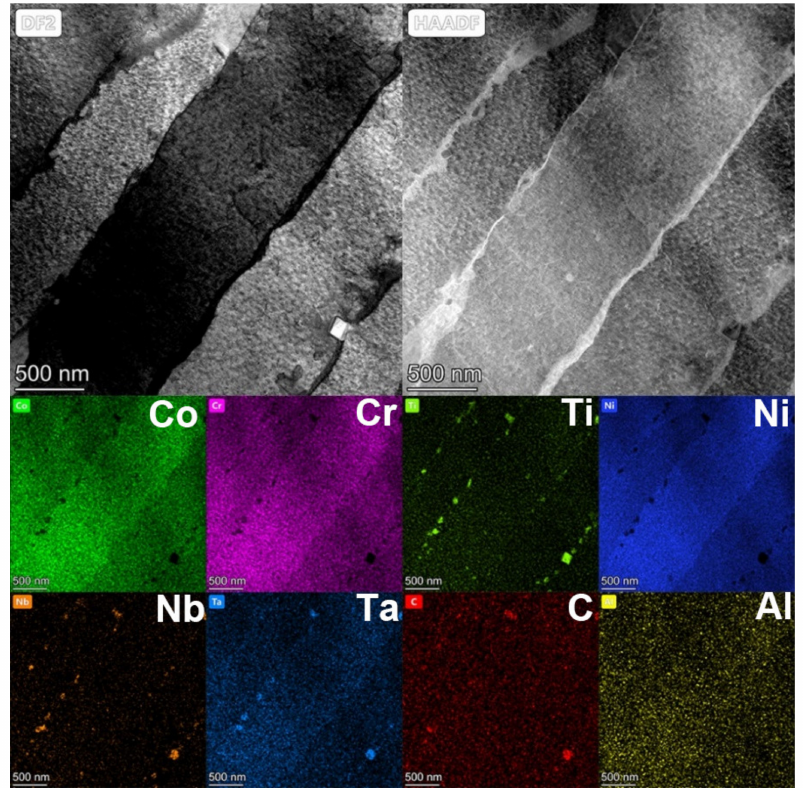
Figure 6. TEM and EDS images of the SLM processed GTD222 after heat treatment. Dark Field (DF), High-angle Annular Dark Field (HADDF).